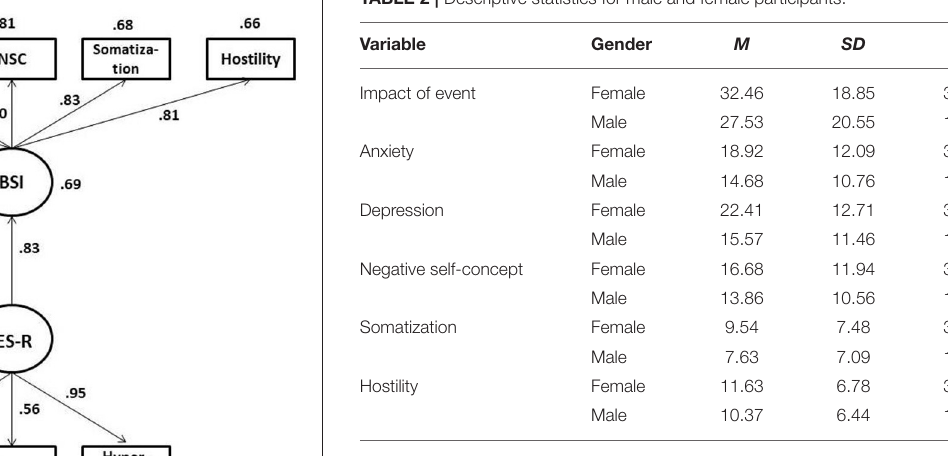
lowest relationship with hostility ( r = 0.62). The hypothesized model was tested, and the fit indices indicated that the model had a strong fit: χ 2 (19) = 71.98, p < 0.001, χ 2 /df = 3.78; CFI = 0.98, TLI = 0.98, GFI = 0.96, RMSEA = 0.07 (90% CI =